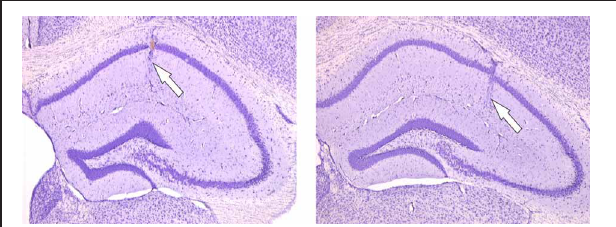
FIGURE 1 | Nissl-stained microphotographs showing the hippocampus electrode positions. Photographs of hippocampal slices following the Nissl staining procedure. The white arrows point approximately to the final position of the recording electrode in the CA1 stratum radiatum dendritic layer on the left photograph and to the final position of the stimulating electrode in the Schaffer collaterals on the right photograph respectively.